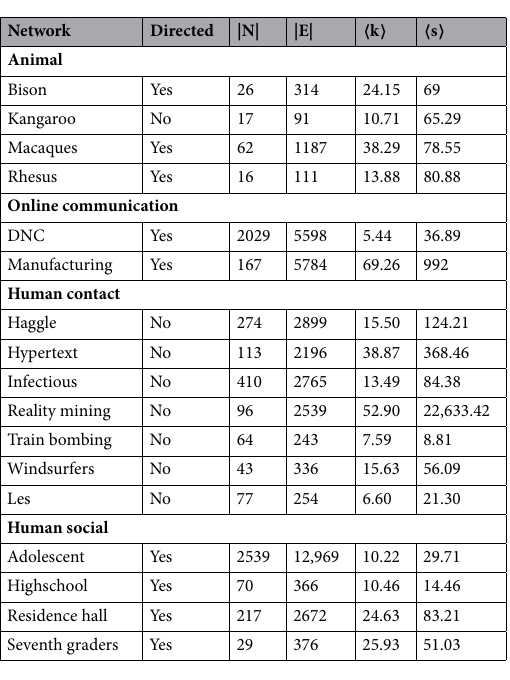
Table 2. The basic statistics of the real networks. These 17 weighted networks include 4 types: animal, online communication, human contact and human social. |V|, |E|, (cid:31) k (cid:31) , (cid:31) s (cid:31) represents the number of nodes, the number of edges, average degree, and average strength of network, respectively.